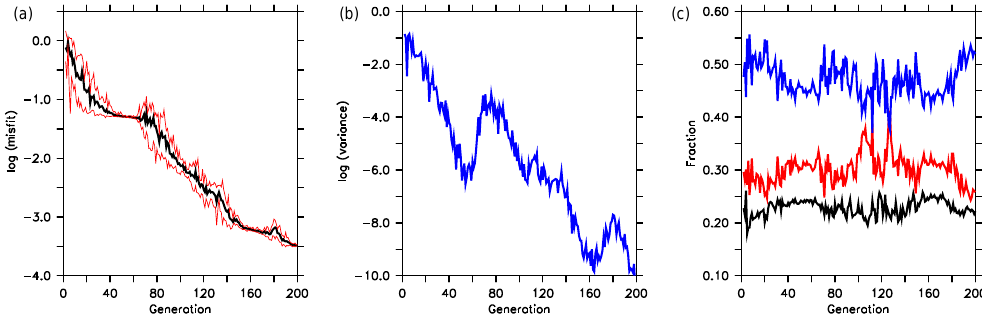
Figure 4. Model misfit, its variance, calculated from individuals of each population (both transformed logarithmically by log 10 ) and compo- nents of the twin experiment. Left panel: the thick black line shows the average misfit of all 10 individuals of a generation. Red lines indicate the maximum and minimum misfit. Mid panel: variance of misfit. Right panel: contribution of each component of the misfit function. Blue: oxygen. Red: nitrate. Black: phosphate.